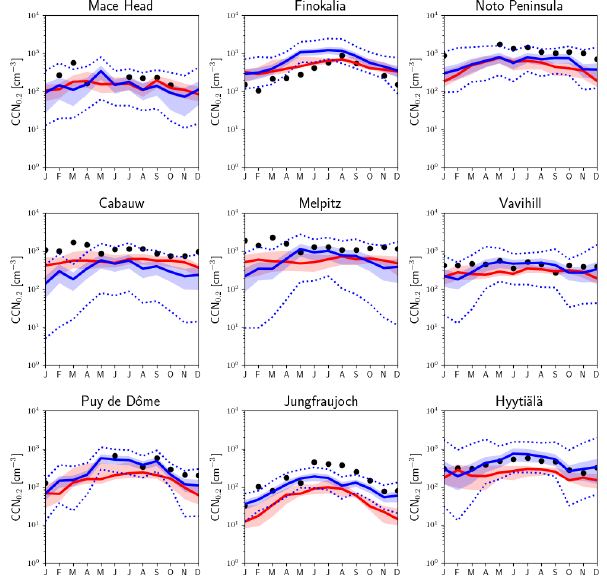
Figure 5. Monthly average CCN 0 . 2 based on HadGEM3-UKCA perturbed parameter ensemble simulations for the year 2008. The solid blue line shows the mean of the sample of 260000 model vari- ants from the emulator for each month and station. The shaded blue area shows the range of this mean plus and minus 1 standard devia- tion, while the blue dashed lines show the minimum and maximum sampled values. The red line shows the MMM results (mean of the years 2011–2015 shown in Fig. 2), and the shaded red area corre- sponds to the 25% and 75% quartiles. The CCN 0 . 2 values obtained from observational data are shown by symbols (mean of the avail- able